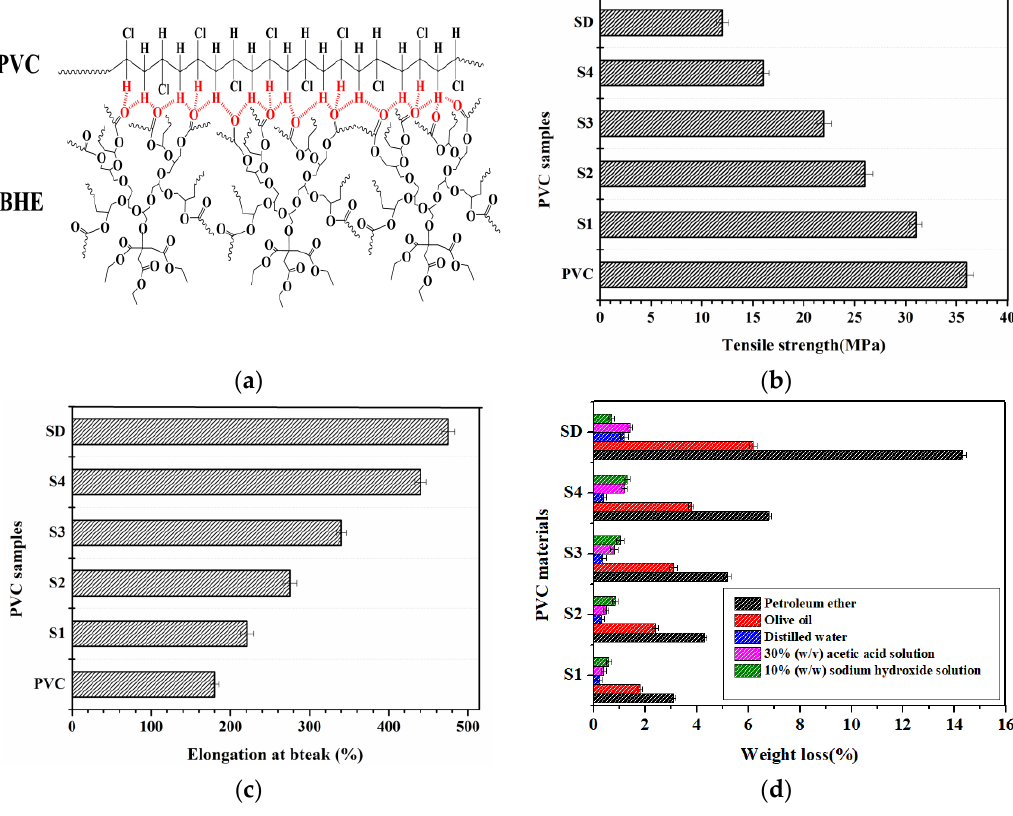
Figure 4. ( a ) Formation of hydrogen bonds; ( b ) tensile strength of PVC materials; ( c ) elongation at breaks of PVC materials; ( d ) solvent extraction resistance of plasticizers.